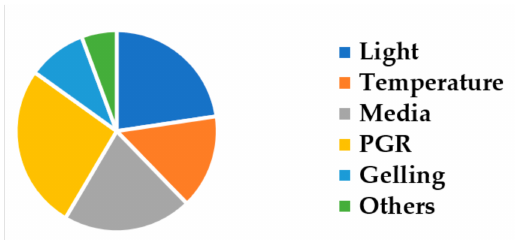
Figure 3. Number of publications on the influence of abiotic factors on callus induction.